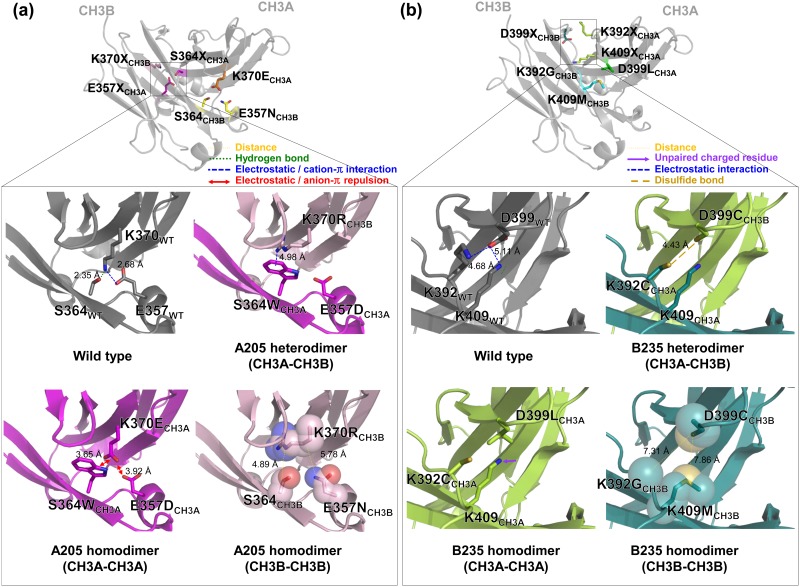
Modeled CH3 domain interface structures of the A205 (a) and B235 (b) variants based on the crystal structure of the EW-RVT variant (PDB code 4X98).Each upper panel shows the overall CH3A-CH3B heterodimer structure of the A107w/o W-VT (a) and B168w/o W-VT (b) variants to show the locations of the targeted mutation sites in LibA2 (a) and LibB2 (b) (as highlighted in the squares) relative to the parent K370ECH3A-E357NCH3B mutation pair in A107w/o W-VT (a) and the D399LCH3A-K392G/K409MCH3B mutation pair in B168w/o W-VT (b), respectively. The lower panels show a close-up view of the newly introduced mutation pair in A205 (E357D/S364WCH3A-K370RCH3B) (a) and B235 (K392CCH3A-D399CCH3B) (b) in a CH3A-CH3B heterodimer, CH3A-CH3A homodimer, and CH3B-CH3B homodimer, compared to the wild type CH3 homodimer. Details are described in the text.